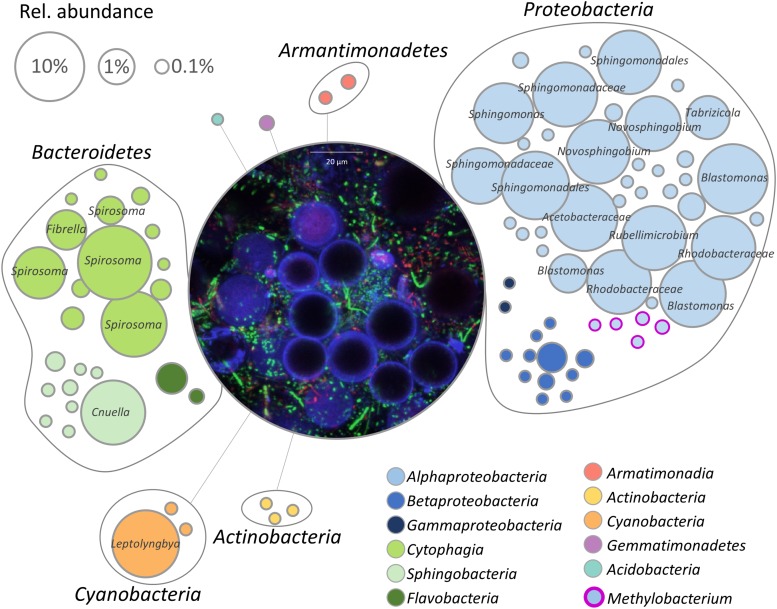
Network visualization of the bacterial community within the biofilm. Each node represents a feature (99% cut-off level), whereas the node size corresponds to their relative abundance. Taxonomy of highly abundant features (>1%) is included. The central micrograph shows the natural microbial community within the biofilm after staining with the LIVE/DEAD bacterial viability kit in combination with calcofluor white (0.15%). Blue: algal cell wall (cellulose, chitin), green: viable bacterial cells, red: dead bacteria.